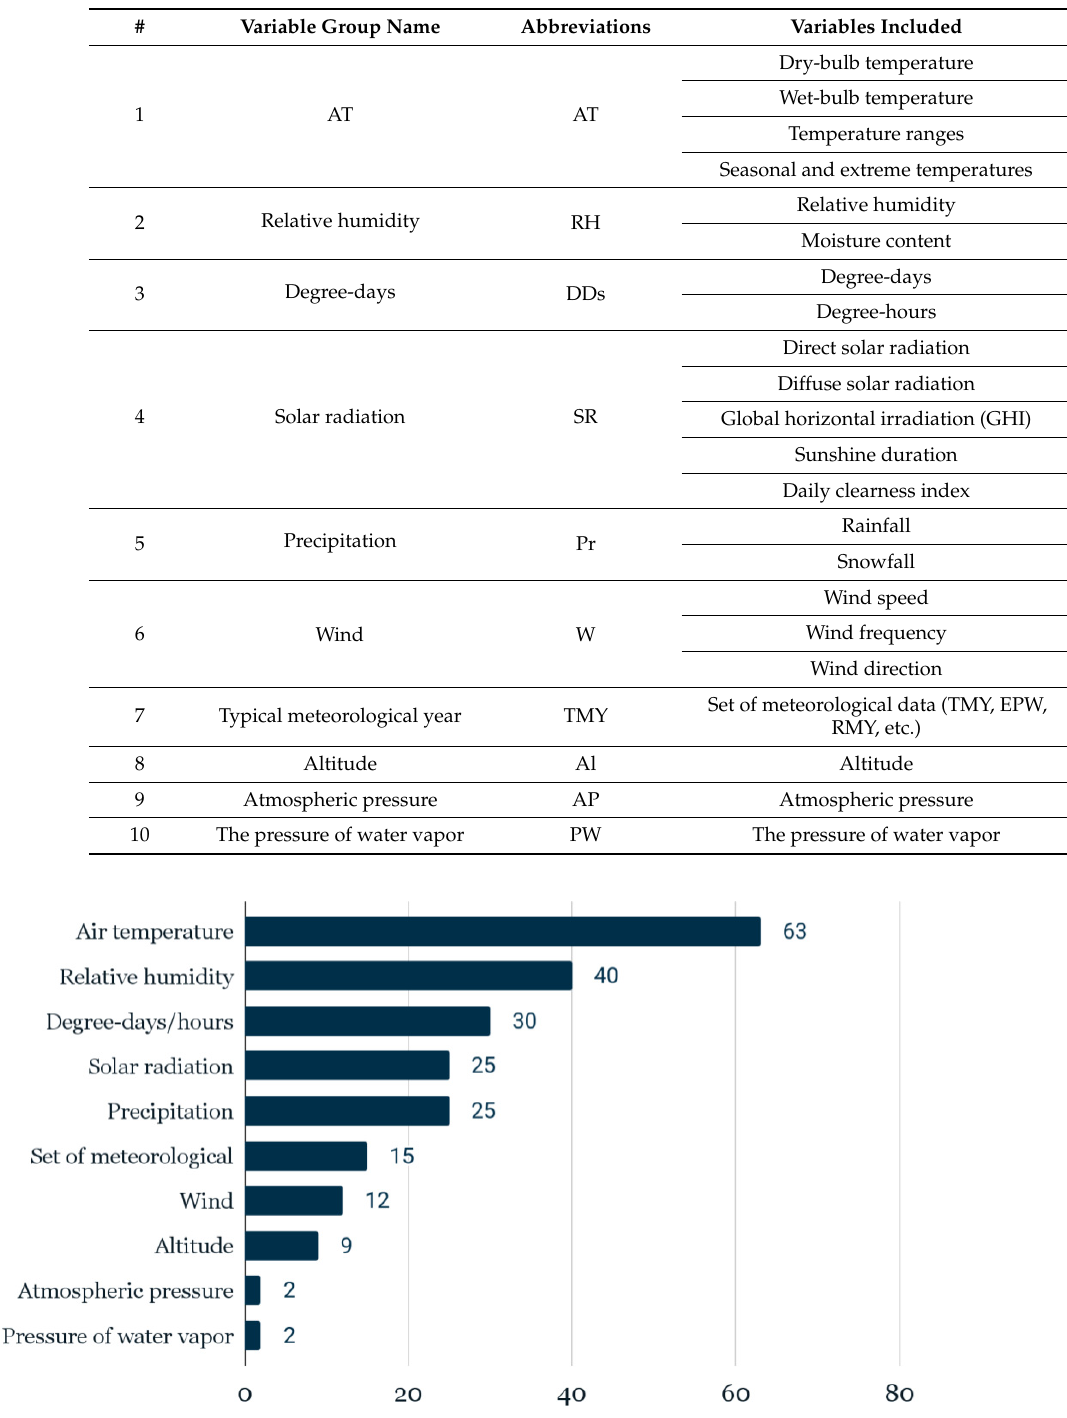
Table 2. CZB variables definitions.